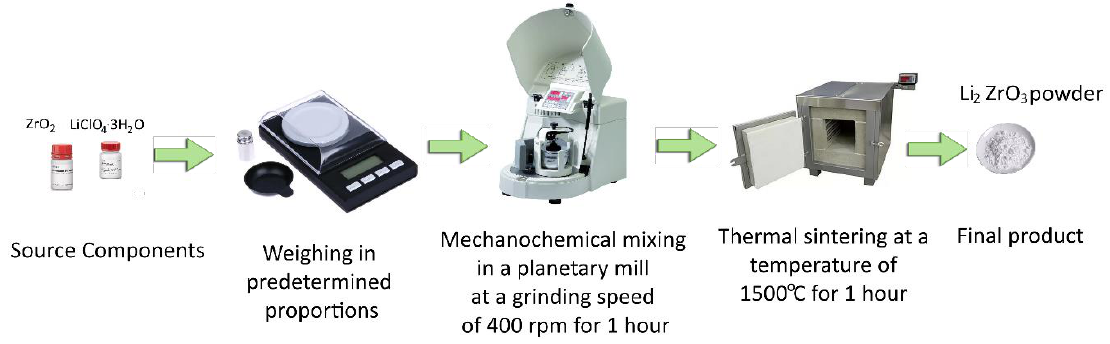
2+4x Zr 4 − x O 3